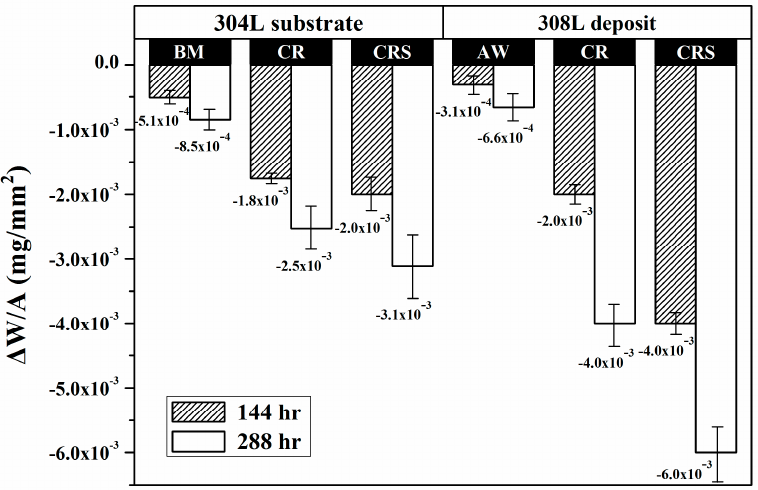
Figure 5. The weight loss of the 304L substrates and 308L deposits in distinct conditions after exposure to a salt